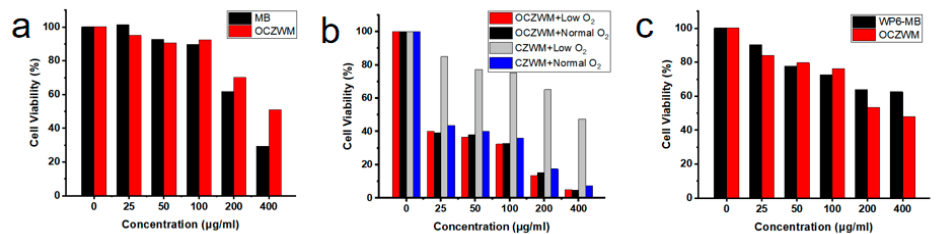
Figure 4. Relative cell viability of ( a ) HL7702 cells and ( b ) HepG2 cells after treatment with OCZWM, Cu/ZIF-8@ZIF-8@WP6–MB at different concentrations. ( c ) Relative cell viability of HepG2 cells after treatment with OCZWM, WP6–MB at different concentrations.